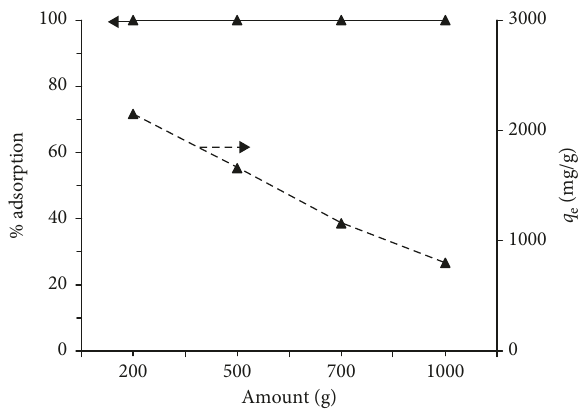
Figure 6: Graphical relationship of percent adsorption, adsorbent dosage, and adsorption capacity at equilibrium under pilot-scale setup using modified